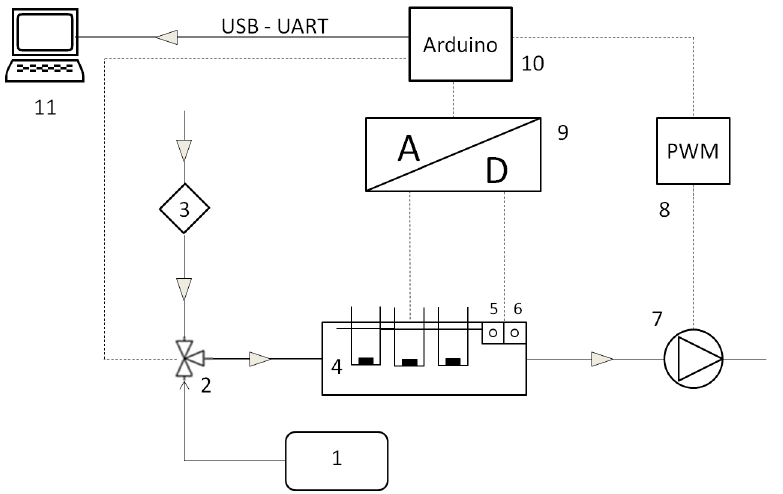
Figure 1. Gas sensor array testing system.